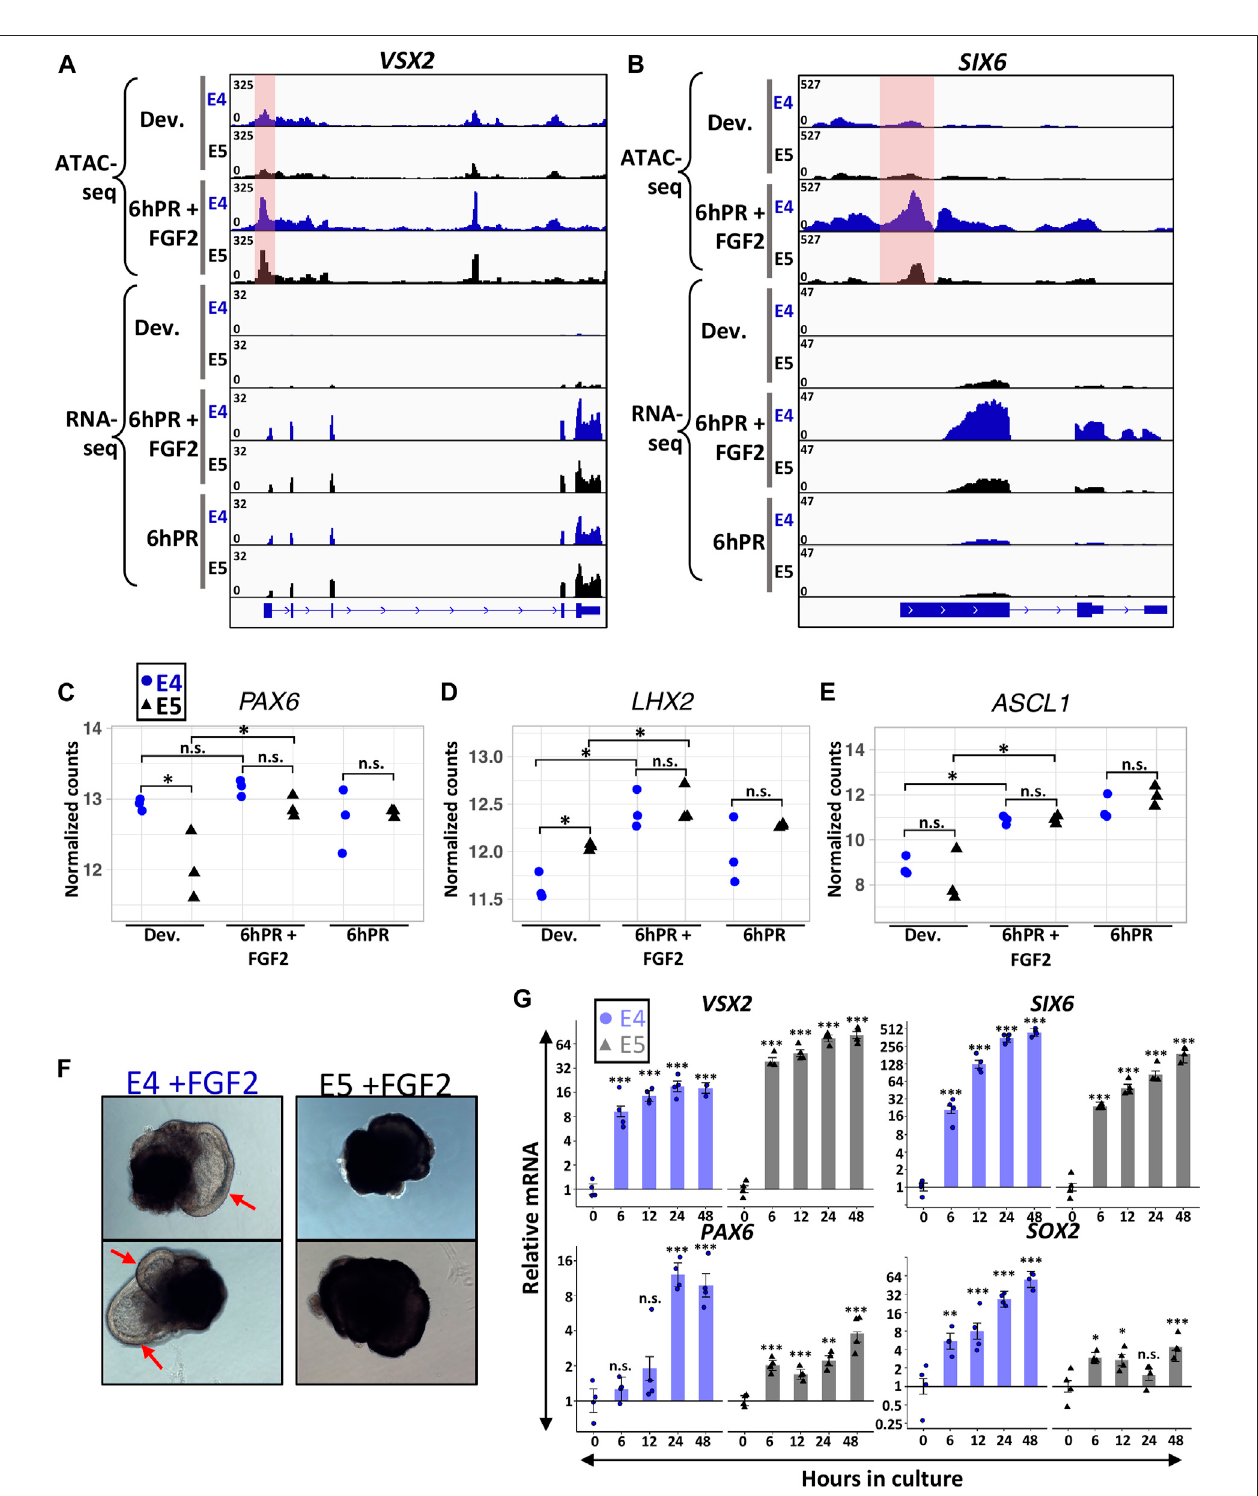
FIGURE 3 | Neural retina identity genes are active 6hPR + FGF2 at E4 and E5. Genome browser views display the VSX2 (A) and SIX6 (B) loci, with the normalized counts for ATAC-seq and RNA-seq assays summarized in the coverage tracks above. The highlighted pink area represents changes in promoter-region accessibility. Normalized gene expression counts are displayed for neural retina-associated genes PAX6 (C) LHX2 (D) and ASCL1 (E) . The y -axes are log-transformed. Asterisk (*) denotes an Adj. p -value ≤ 0.05. n.s., not signi fi cant. (F) Two representative RPE explants are shown after 48 h in culture in the presence of FGF2 at E4 (left) or